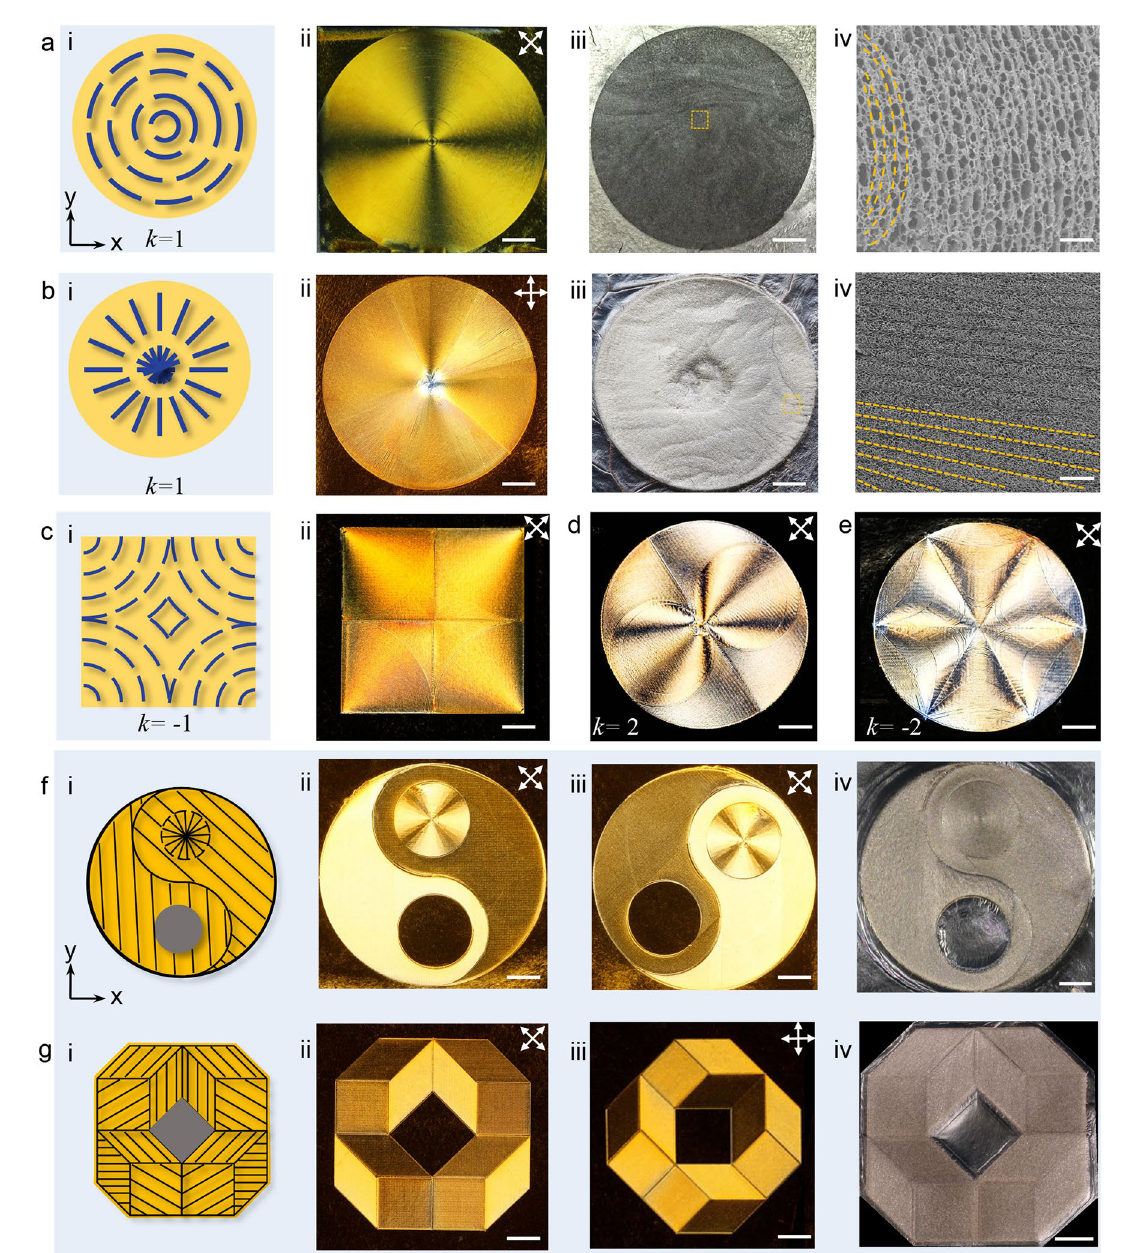
Fig. 6 Topological configuration: a concentric-circle structure, b hedgehog topology with topological intensity of + 1, c the structure with topo- logical intensity of − 1, d the structure with topological intensity of 2, and e the structure with topological intensity of -2. In each panel: (i) sheet arrangement profile, (ii) POM image, (iii) dried skeletons, and (iv) SEM images. Controllable polydomain: f Tai Chi pattern, g cell of quasi- crystalline with 8 rotational symmetry. In each panel: (i) sheet arrangement profile, (ii-iii) polarized texture before and after clockwise rotating the sample by 45°, (iv) dried skeletons. All images were from top view. Scale bars: a − c (iv) 200 µm; others 1